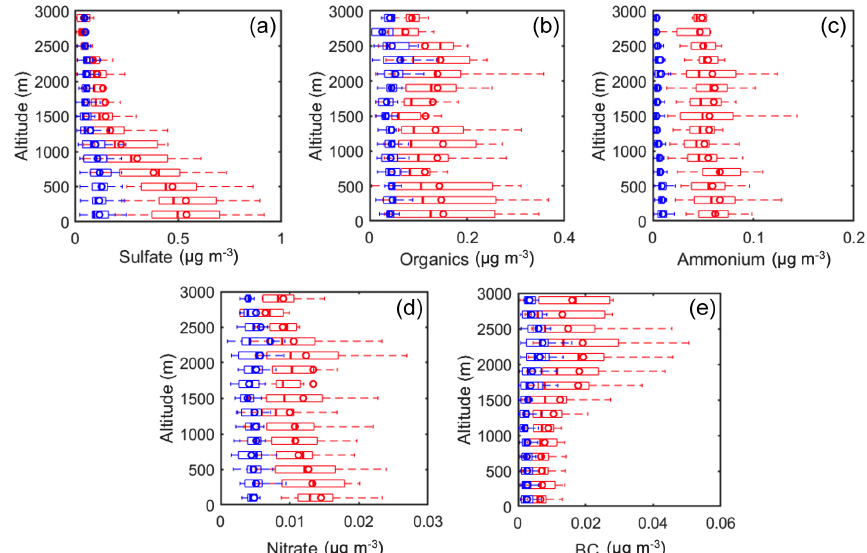
Figure 7. Vertical profiles of the mass concentrations of (a) sulfate, (b) organics, (c) ammonium, (d) nitrate, and (e) black carbon (BC) in the ENA during the summer IOP (red) and winter IOP (blue). BC is measured by the SP2, and the rest of the compositions are measured by the HR-ToF-AMS. The line and circle markers represent the median and mean of the data, and the edges of the box indicate the 25th and 75th percentiles, respectively. The concentrations are normalized to standard temperature and pressure (273.15K and 101.325kPa;